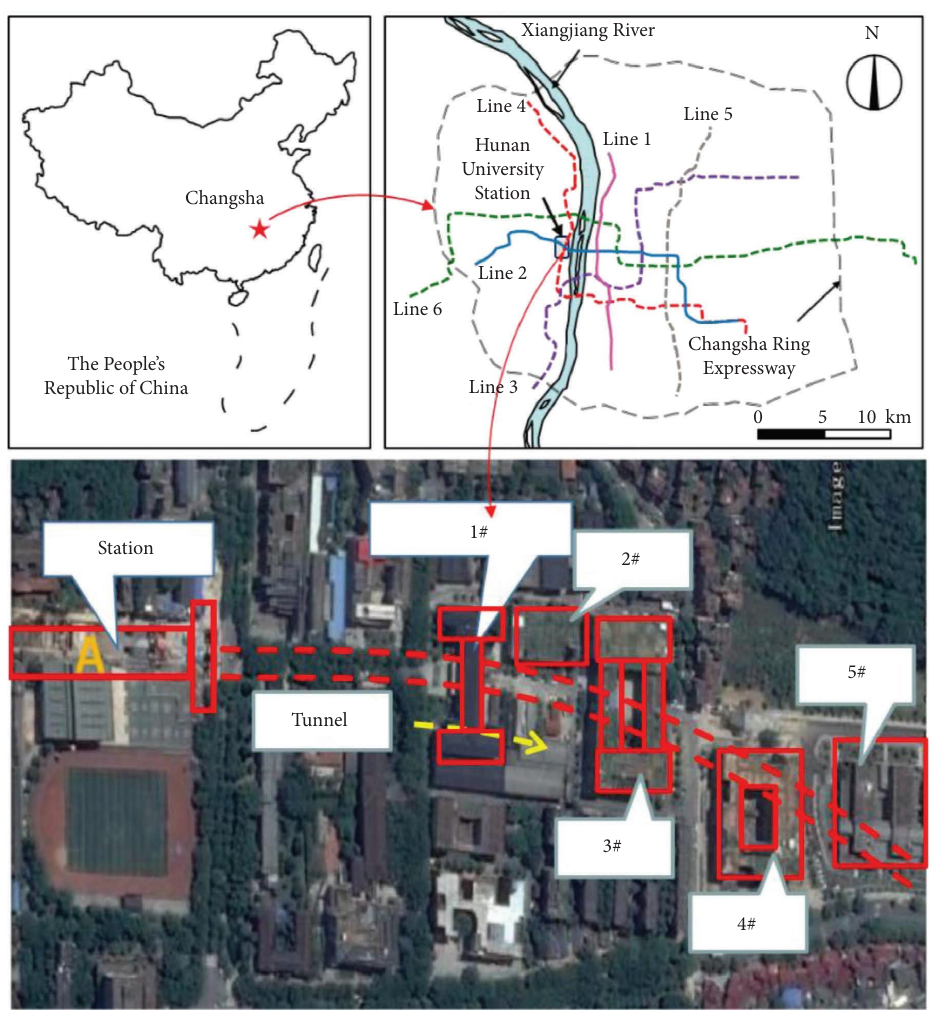
Figure 3: Distribution of Changsha metro lines and location of buildings [47].